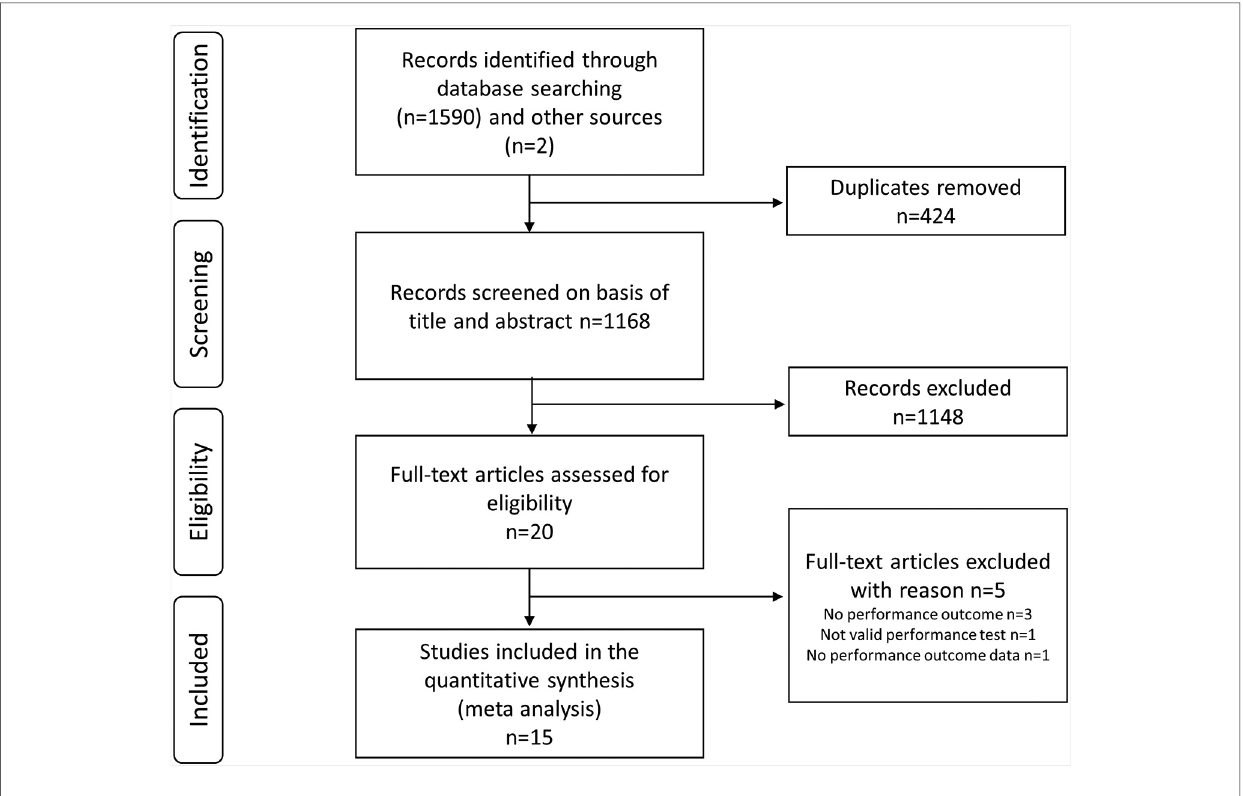
FIGURE 1 Flow chart of included studies as proposed by preferered reporting items for systematic reviews and meta-analyses statement